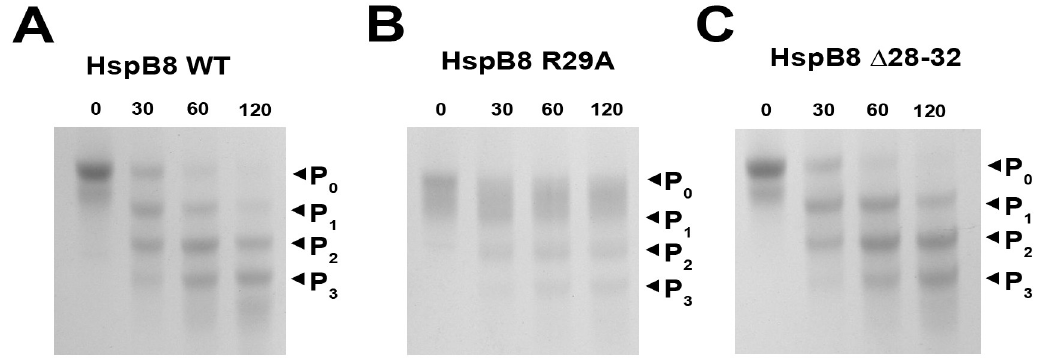
Fig 6. Urea gel-electrophoresis of HspB8 WT (A), and its R29A (B) and Δ 28–32 (C) mutants in the course of phosphorylation by ERK1. Incubation time (min) is indicated above each lane. Arrows next to P 0,1,2,3 represent bands of proteins carrying 0, 1, 2 or 3 phosphate groups,